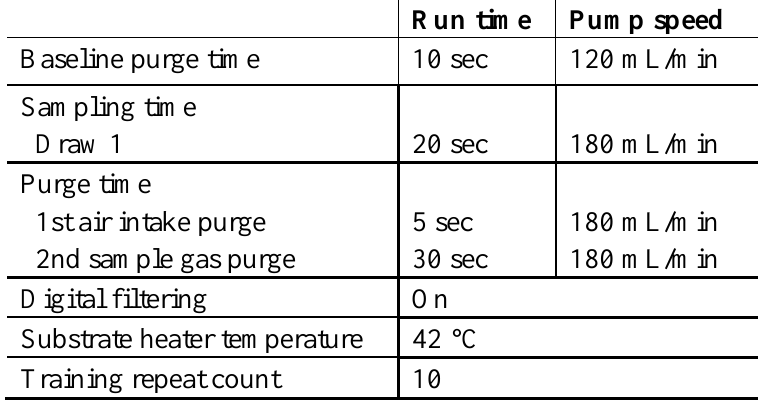
Table 2. Cyranose 320 parameter set up for sampling agarwood